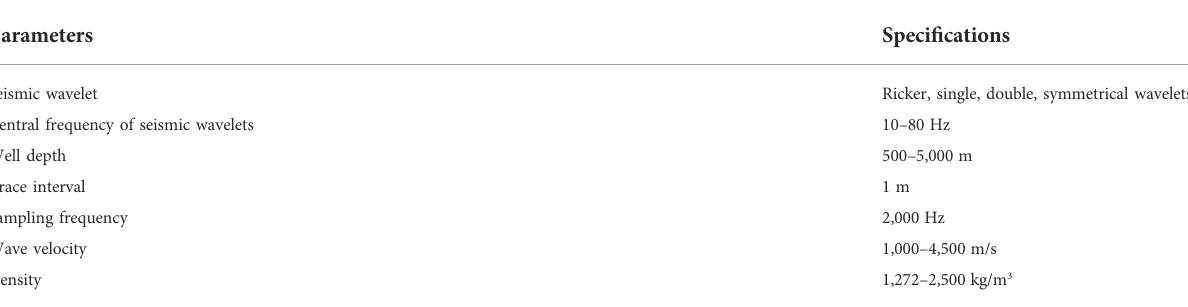
TABLE 1 Physical parameters for the forward